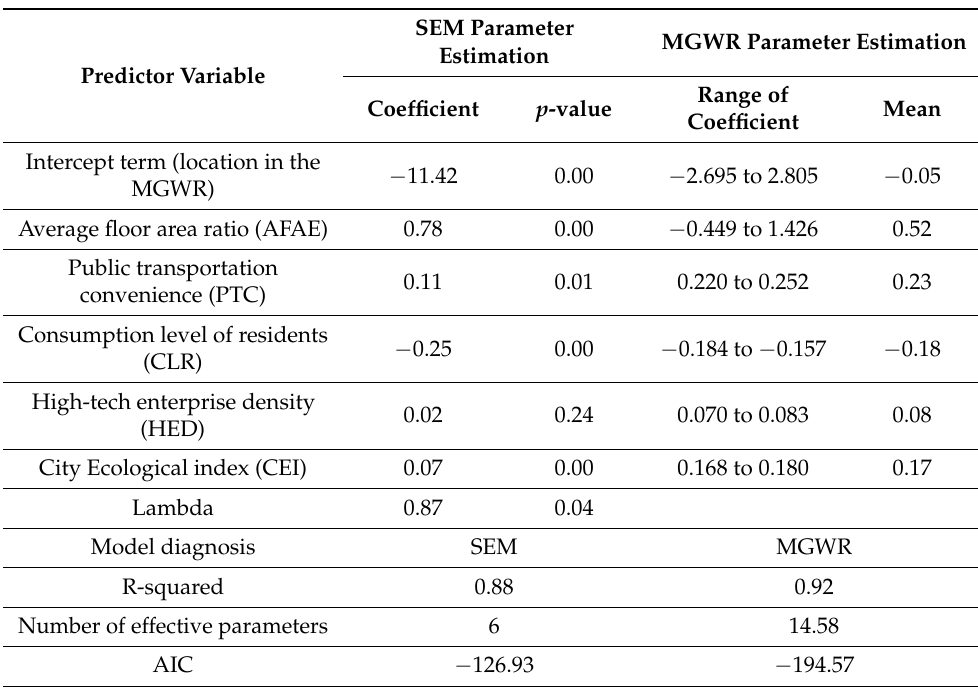
Table 5. Comparison of the parameters and regression coefficients of the SEM and MGWR